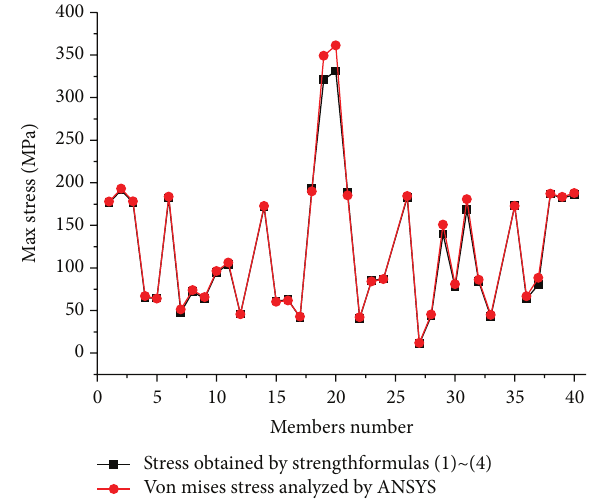
Figure 14: Comparison of results between strength formulas and finite element analysis.